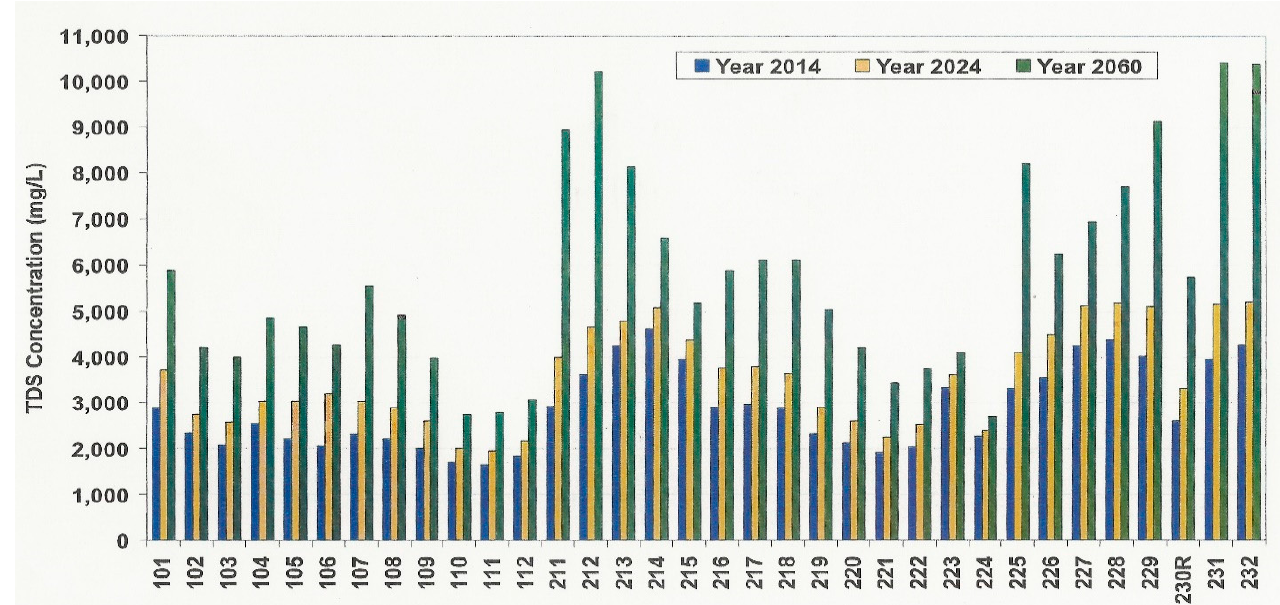
Figure 11. Projected individual well TDS concentrations for the South Wellfield in the Lower Hawthorn Aquifer [13].